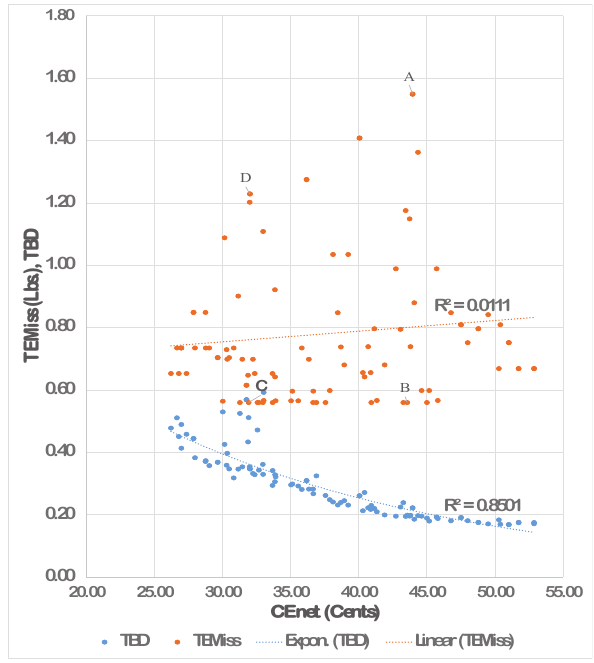
Figure 15. Variations in total GHG emissions during the scheduling horizon TEMiss with the related trade-offs for net cost of energy CEnet and time-based discomfort TBD